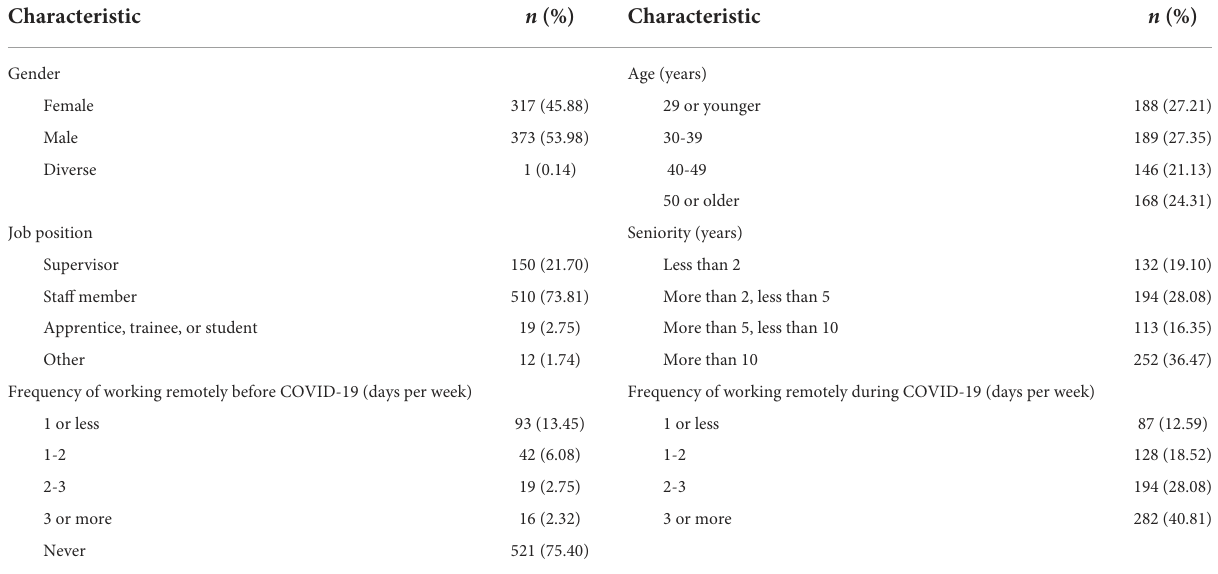
TABLE 1 Respondent